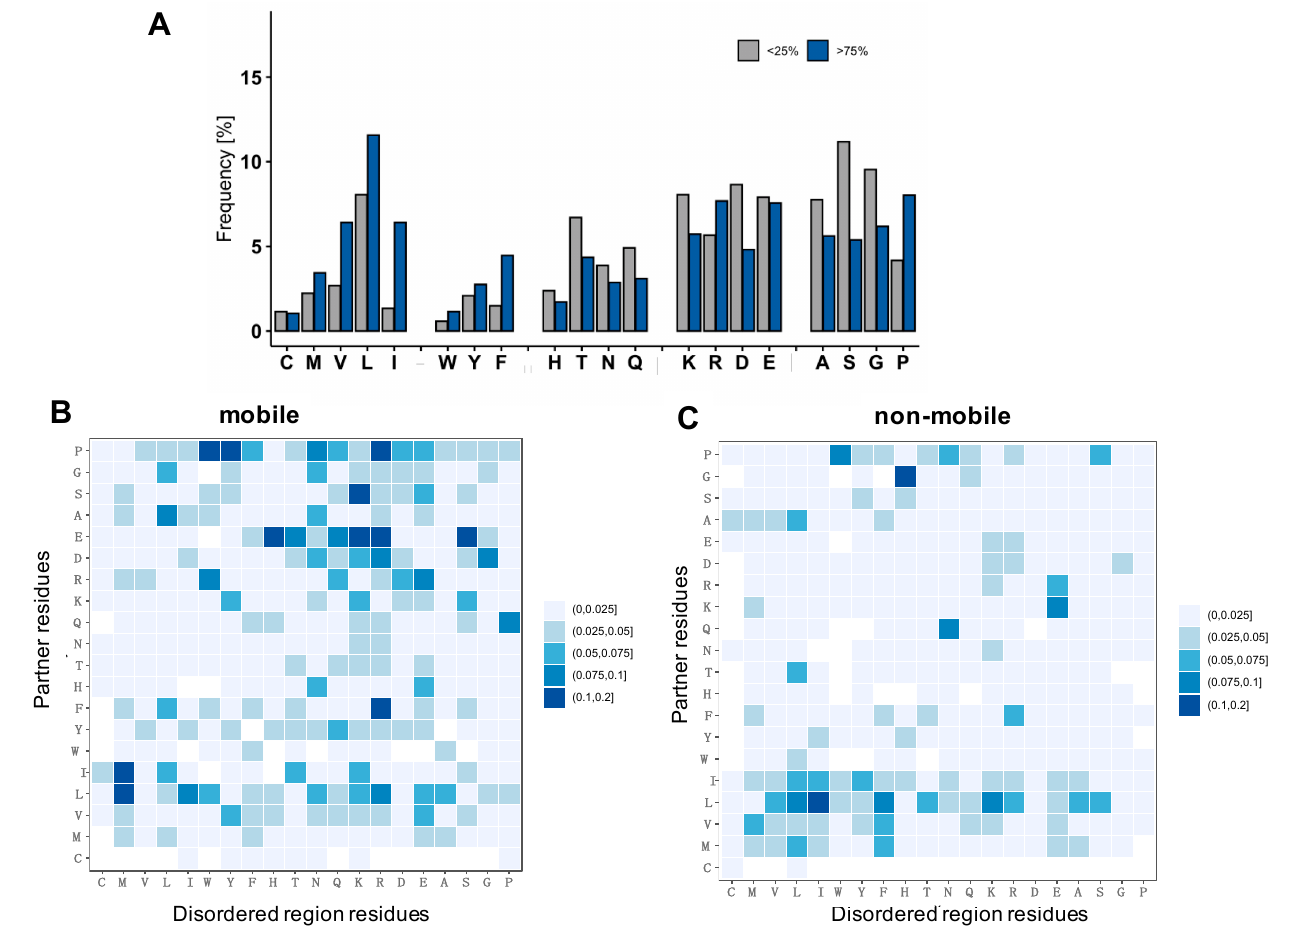
Figure 6. Compositional analysis of interfaces of droplet-driving proteins. ( A ) Composition of residues that establish persisting (f C = N C /N TOTAL ≥ 0.75, blue) and transient (f C = N C /N TOTAL ≤ 0.25, gray) contacts with the partner. Amino acids are grouped as hydrophobic, aromatic, polar and aggregation, promoting charged and disorder-biasing [27] residues. ( B , C ) Frequencies of contacting amino acids (F ij , Methods) in mobile ( B ) and non-mobile ( C ) residues. The x -axis shows the amino acids of the droplet/disordered region, and the y -axis shows the amino acids of the binding partner. The contacting frequency was computed by counting for the different types of contacts divided by the total number of contacts in each ensemble and taking the median value for all complexes. The color scale is shown on the right, frequencies were multiplied by 10 for visual clarity (Methods, Equation (5)). While mobile contacts are established mostly between polar and charged residues, non-mobile contacts are mostly based on hydrophobic and aromatic contacts.